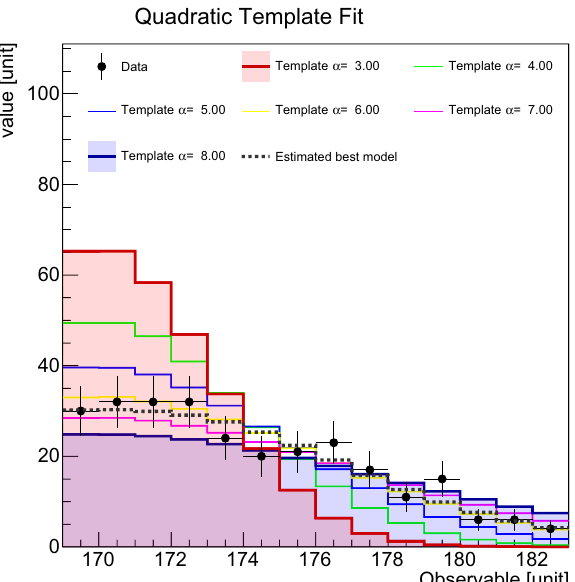
templates, as is used by the Quadratic Template Fit. The green dashed line indicates the linearization at the best estimator, and the red dotted line indicates the linear regression of the templates as it would be used by the plain Linear Template Fit